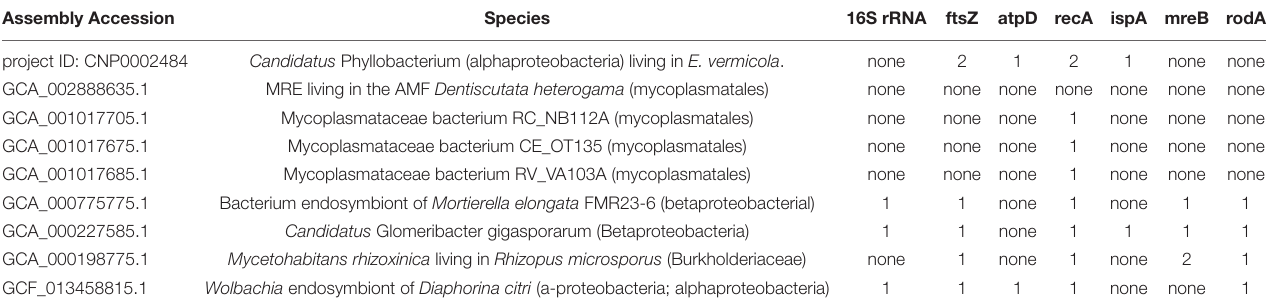
TABLE 1 | Presence or absence of conserved genes in endobacteria of fungi (8) and insect (1). Assembly Accession Species 16S rRNA ftsZ atpD recA ispA mreB